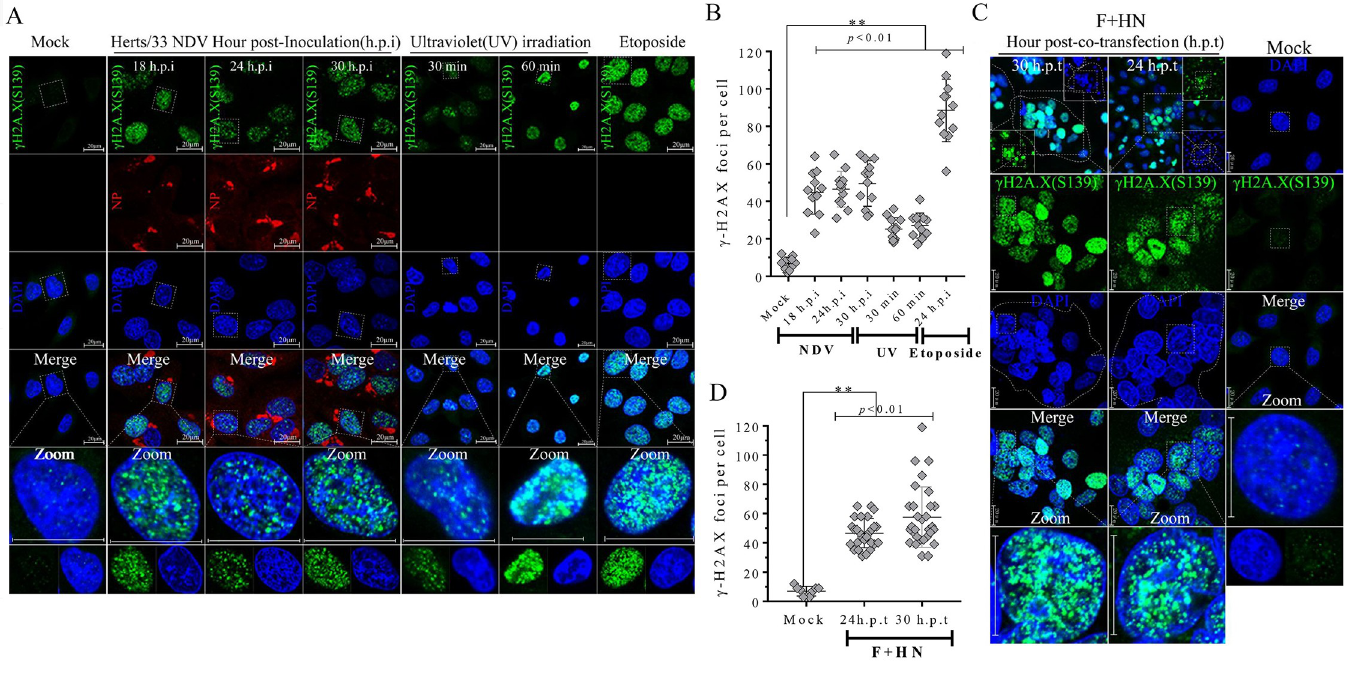
Fig 3. Aggregation of γ -H2A.X punctuate foci in nuclei were induced by virulent NDV infection and membrane fusion. (A) Representative images showing that virulent oncolytic NDV infection triggered the nuclear aggregation of γ -H2A.X in A549 cells. A549 cells were mock-infected, NDV-infected (MOI = 1), inoculated for 18, 24, and 30 h, UV exposed for 30 and 60 min, and treated with etoposide at a final concentration of 80 μ m for 24 h. After treatment, the A549 cells were collected, fixed, and visualized by IFA. The UV and etoposide treatment groups were used as positive controls. γ -H2A.X (green); Nuclei (blue); NDV (red). Scale bars = 20 μ m. (B) Statistical analysis of the nuclear aggregation punctate foci number of γ H2AX in response to virulent oncolytic NDV infection in A549 cells. Numerical data were the average number of punctate foci in different microscope fields in at least three independent experiments. Significance was analyzed using two-tailed Student’s t-test. NS, p > 0.05; � , p < 0.05; �� , p < 0.01; ��� , p < 0.001. The UV and etoposide groups served as positive controls. (C) Representative images showing that F-HN co-expression triggered the nuclear aggregation of γ -H2A.X in A549 cells. A549 cells were mock-transfected or co-transfected with both Flag-F and HA-HN plasmids at the indicated timepoints. At 24 and 30 h.p.t., the coverslips were examined by IFA. γ -H2A.X (green); Nuclei (blue); NDV (red). Scale bars = 20 μ m. (D) Statistical analysis of the nuclear aggregation punctate foci number of γ -H2A.X in response to F-HN